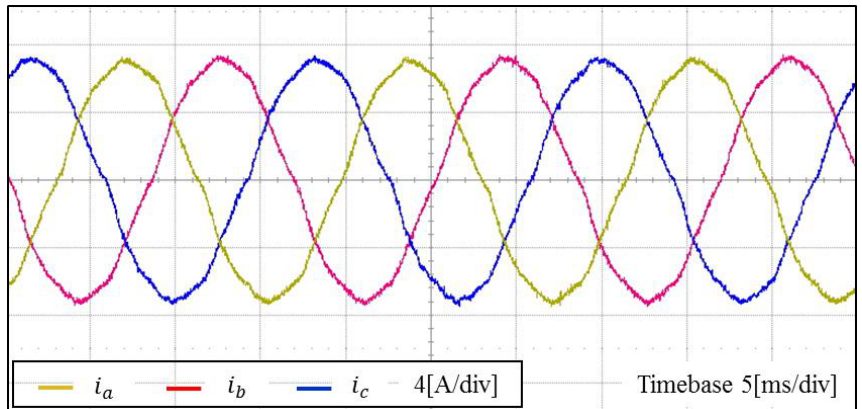
Figure 22. Experimental results for inverter output currents using the proposed control scheme under the distorted grid voltages.